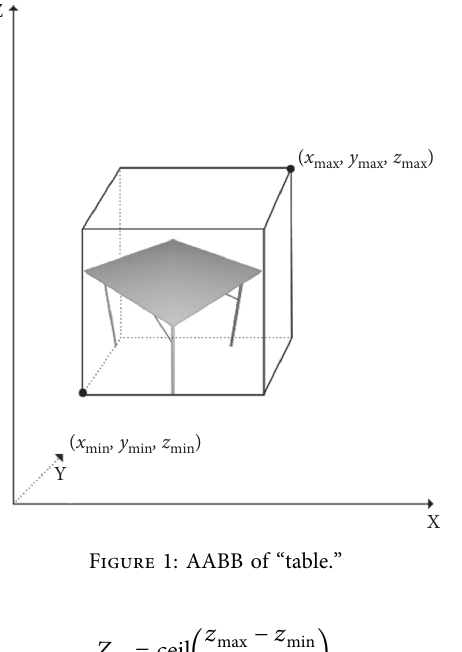
Figure 1: AABB of